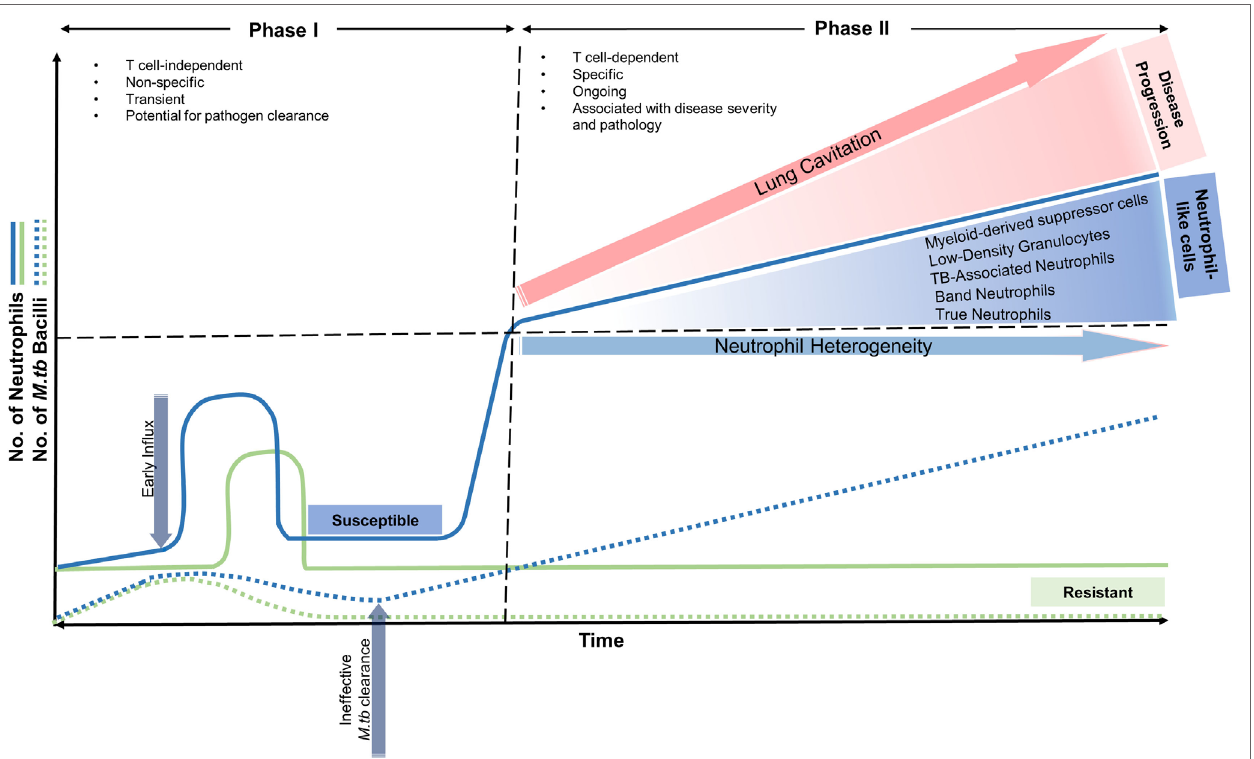
FigURe 1 | Neutrophil recruitment into the lung in resistant and susceptible individuals over time in early and advanced stages of Mycobacterium tuberculosis infection. In resistant individuals, neutrophil influx occurs soon after infection, where along with macrophages, aid in removing M. tuberculosis effectively. Neutrophil numbers return to baseline and a minimal effect on the host is observed. In susceptible individuals, phase I begins soon after infection and is characterized as T cell-independent, non-specific, and transient with the potential for pathogen clearance. Phase II is characterized as T cell-dependant, specific, and ongoing and is associated with disease severity and pathology. During this stage, and as the disease progresses, an increase in the number of neutrophil-like cells (NLC) circulating in the blood and those from lung tissue are observed. They present as immature or undifferentiated precursor cells in the form of myeloid-derived suppressor cells (MDSC), tuberculosis-associated neutrophils (TBAN), low-density neutrophils, and band neutrophils. The second phase of exacerbated neutrophil influx is also associated with lung cavitation and disease